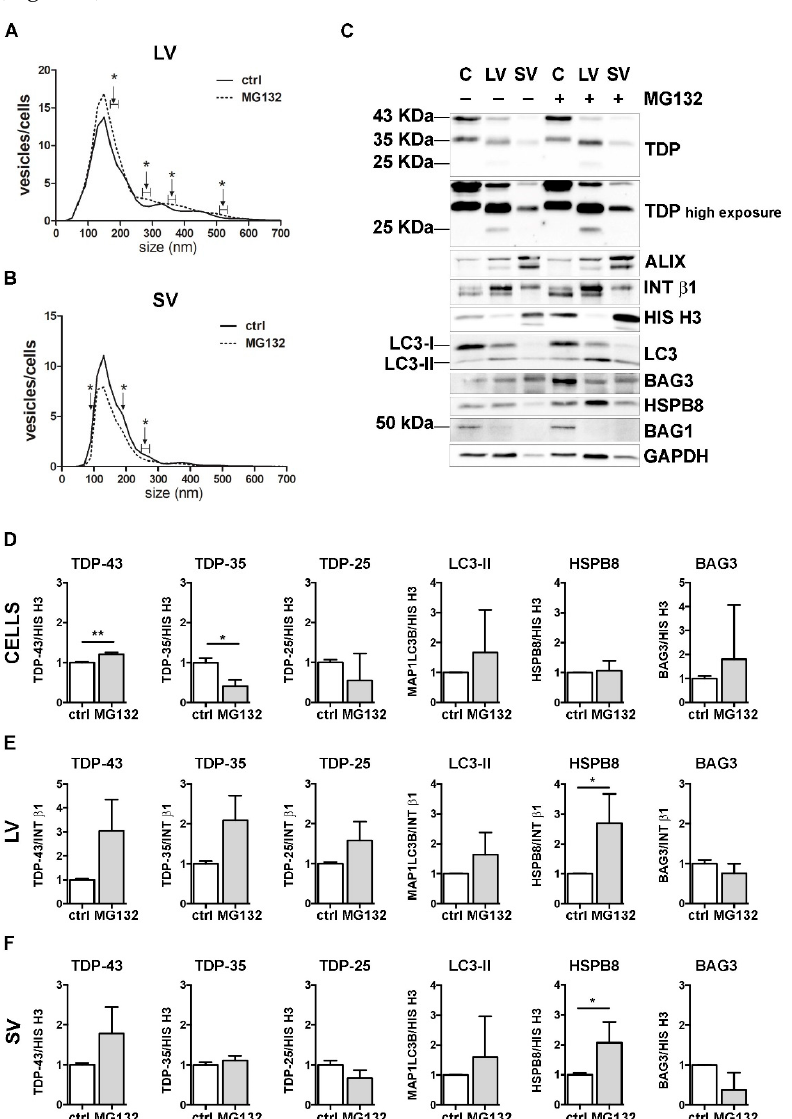
Figure 3. The effect of UPS inhibition on the EVs number and protein content. ( A , B ) NTA distribution of LVs ( A ) and SVs ( B ) isolated from NSC-34 cells treated overnight (o/n, 16 h) with